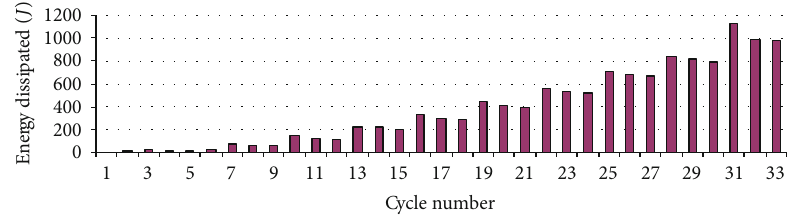
Figure 8: Energy dissipation of column SWM1-1.